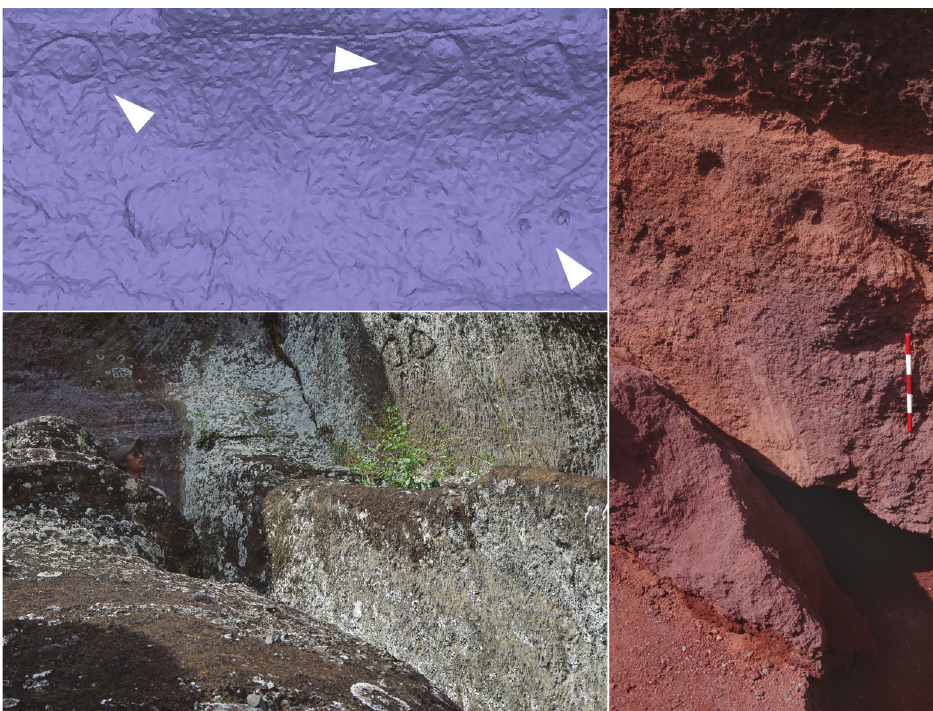
Fig. 5: Carved eyes at the Puna Pau and Rano Raraku quarries. Clockwise from top left: 3D- photogrammetry image of a single eye and pairs of lenticular and round carved eyes at Rano Raraku (A. Stanford); the pair of carved circular eyes in the interior of the Puna Pau crater; and a pair of carved lenticular eyes on the side of a Rano Raraku quarry bay (photos: M. Seager